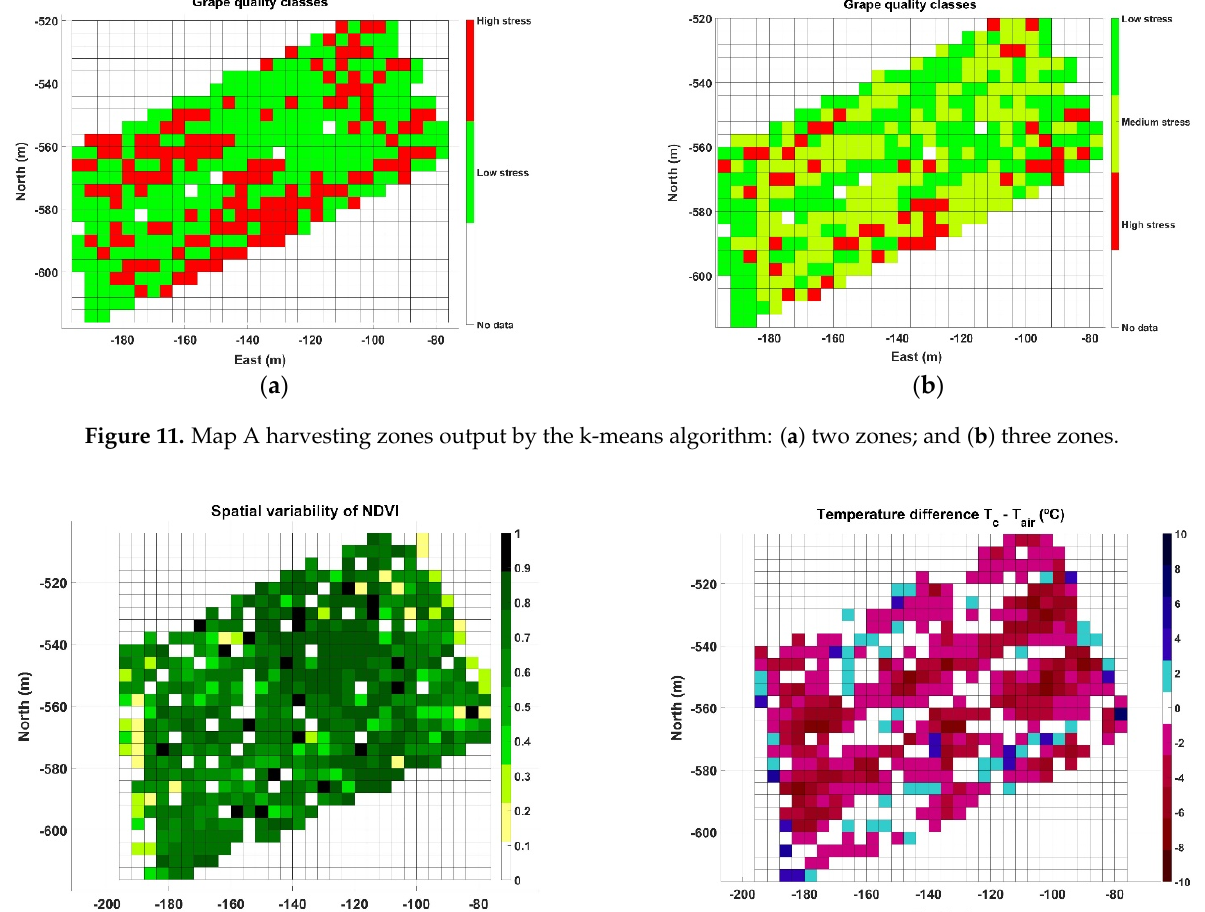
Figure 11. Map A harvesting zones output by the k-means algorithm: ( a ) two zones; and ( b ) three zones.